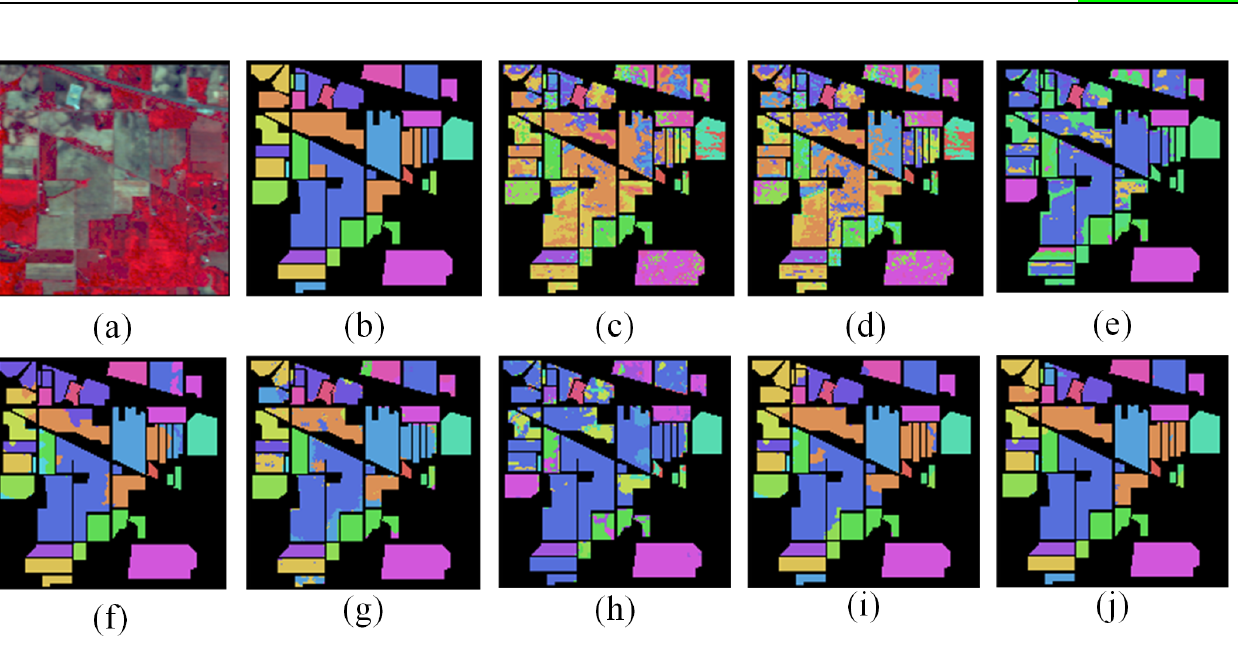
Figure 6. Classification maps of different methods on Indian Pines dataset; ( a ) Composite RGB image. ( b ) Groundtruth map. ( c ) SVM; ( d ) 3D-CNN; ( e ) 1D+2D; ( f ) GCN-M; ( g ) KDCDWBF; ( h ) STSE_DWLR; ( i ) SGL; ( j ) MSGLAMS